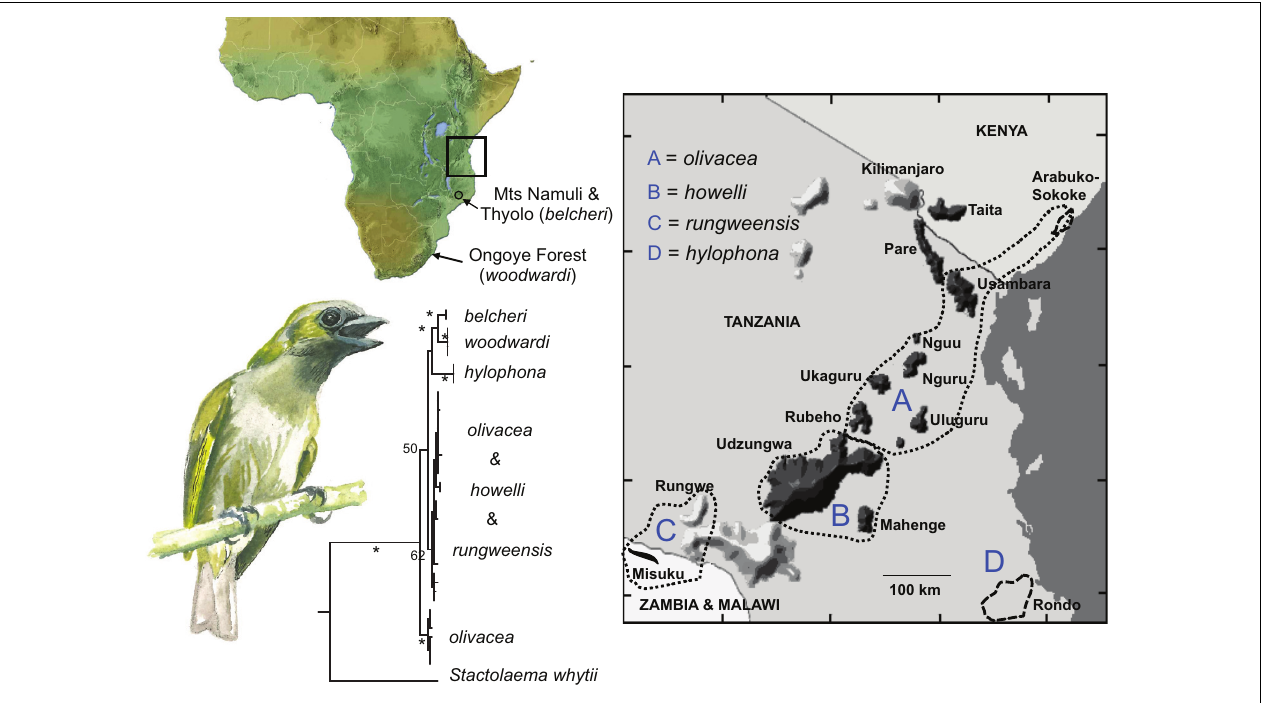
FIGURE 7 | Top Left Panel: Distribution map of the Green Barbet Stactolaema olivacea . Right Panel: An enlargement of the box demarcated on the map of Africa depicting the distribution of Green Barbet subspecies across Tanzania and extreme northern Malawi. Bottom Left: Mitochondrial DNA (Cytb, ND3) phylogeny of Green Barbet populations across east and southern Africa derived from a partitioned maximum likelihood analysis. * > 75% bootstrap